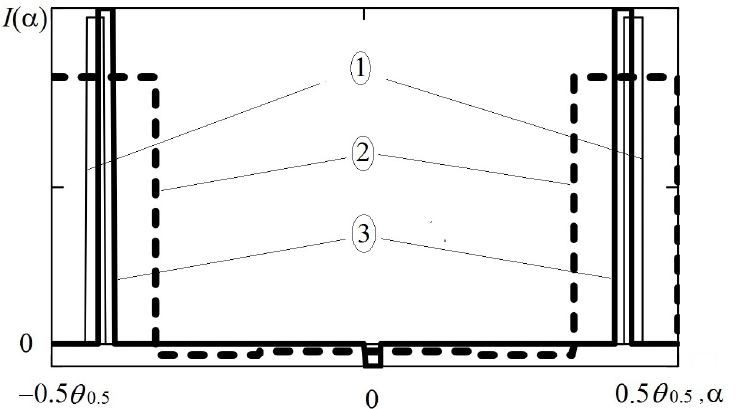
Figure 1. Image reconstruction of two point sources: 1-signal sources; 2-solution found by the usual algebraic method; 3-solution obtained on the basis of a modification of the algebraic method.